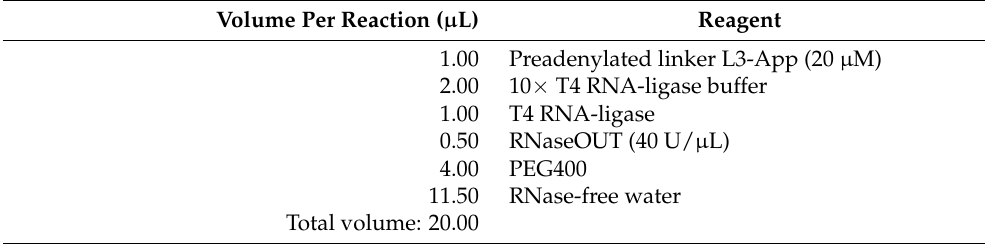
Table 5. Ligase Mix for On-Bead 3’ Linker